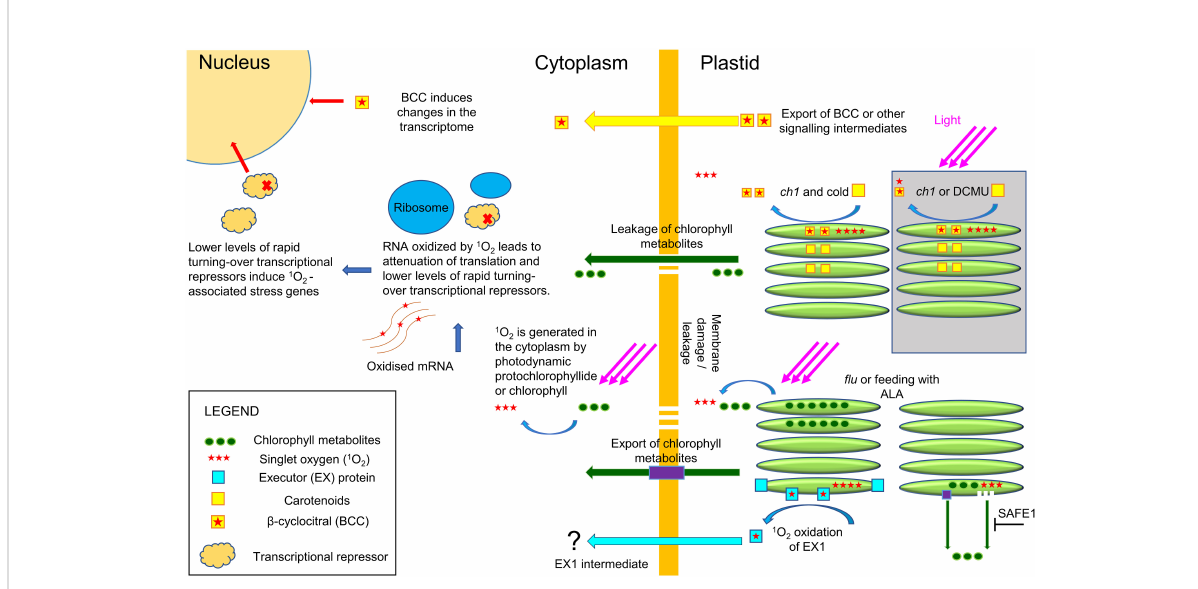
FIGURE 9 Plastid and cytoplasmic origins of 1 O 2 . The fl u mutant in the dark, or application of ALA, leads to the accumulation of chlorophyll metabolites and production of 1 O 2 in the cytoplasm in the light. It is currently unknown if the export of these metabolites occurs via specialized transport proteins or via membrane leakage. In the cytoplasm, 1 O 2 ef fi ciently and selectively oxidizes guanosine residues in RNA that then inhibit translation lowering the levels of rapidly turning over repressors of transcription. The decrease in repressors will initiate the 1 O 2 transcriptome signature that resembles the transcriptome of CHX, an inhibitor of 80S ribosome translation. The EX1 mutant pathway has been shown to attenuate fl u -mediated cell death, but how EX1 signals are transported outside the chloroplast and elicits nuclear signaling is currently unknown. In the light, the ch1 mutant or application of DCMU will induce 1 O 2 locally in the chloroplast and initiate a transcriptome response that is distinct from cytoplasmic 1 O 2 (area in grey). It has been shown that BCC can serve as a signaling intermediate in the Ch1 mutant and HL stress, but its mechanism of action is currently unknown. However, under conditions of high light and cold the increased levels of 1 O 2 initiate chloroplast leakage and production of 1 O 2 in the cytoplasm leading to a 1 O 2 transcriptome signature of cytoplasmic